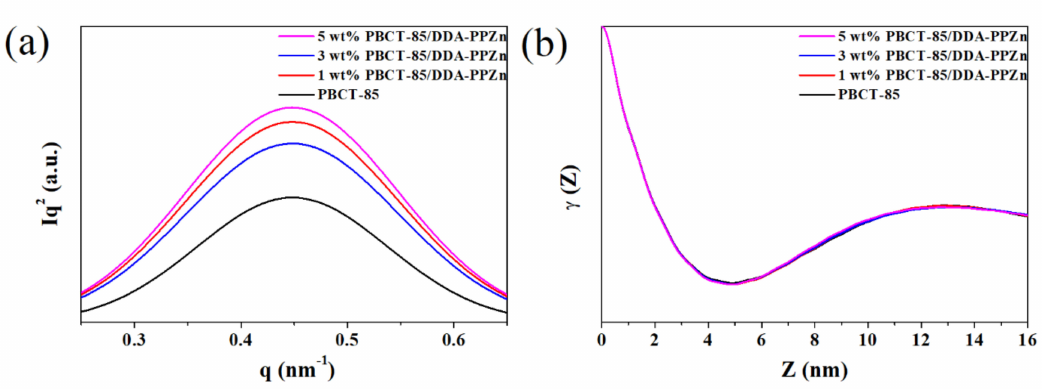
Figure 5. ( a ) Lorentz-corrected SAXS profiles and ( b ) one-dimensional correlation function calculated from the SAXS profiles for PBCT-85 / DDA-PPZn